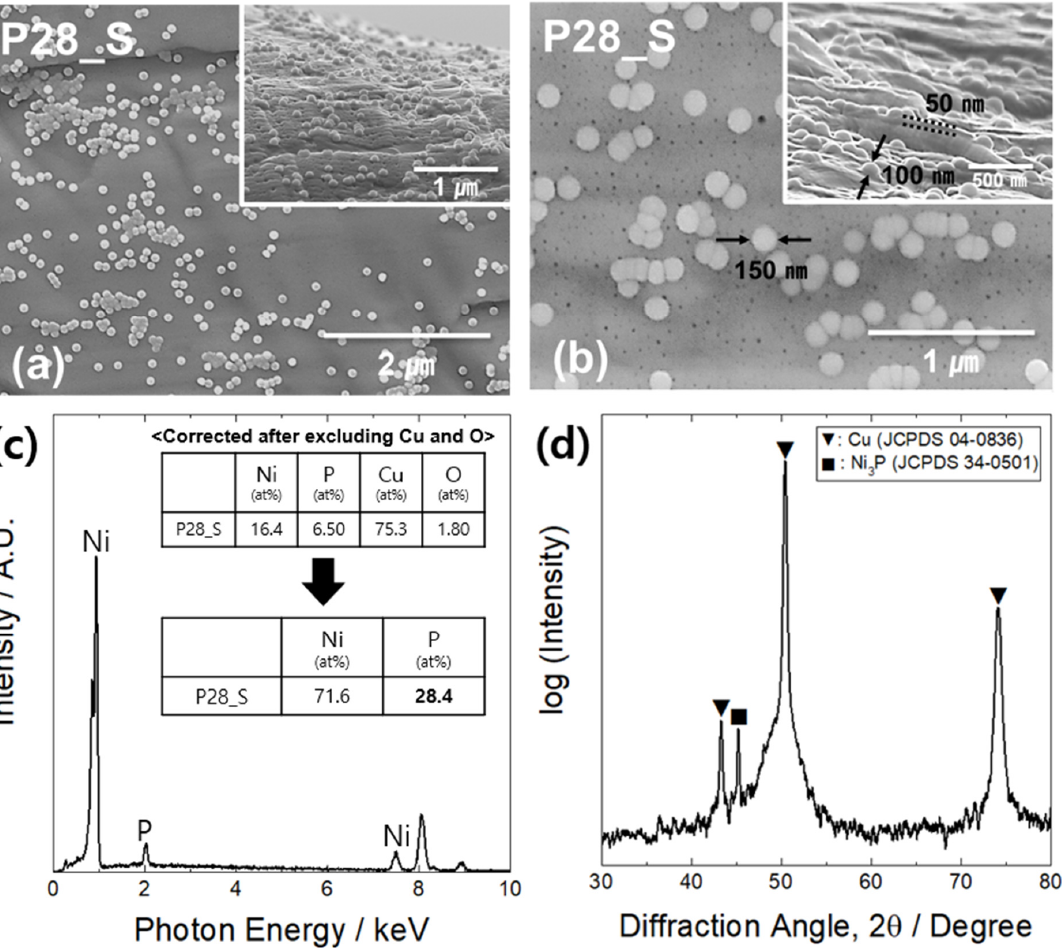
Figure 7. ( a ) Surface and inclined images of a Ni-P thin film partially covered with spherical electrodeposits (sample P28_S) and ( b ) their magnified images. ( c , d ) represent the EDS and XRD analyses of P28_S, respectively.